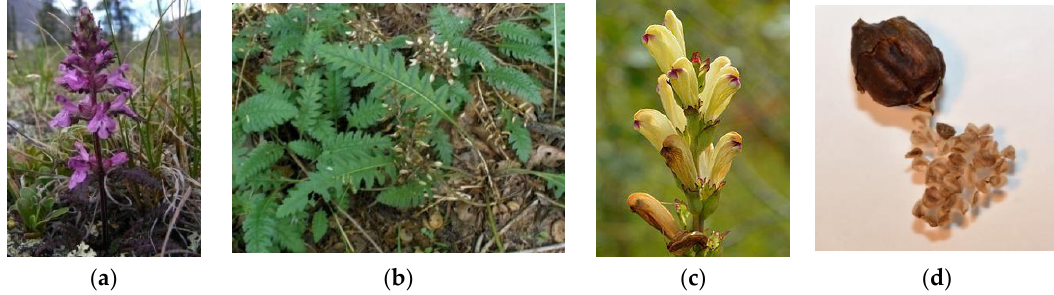
Figure 1. Examples of the morphological features of Pedicularis species—stem ( a ), leaves ( b ), flowers ( c ), fruits ( d ) [source Google images].